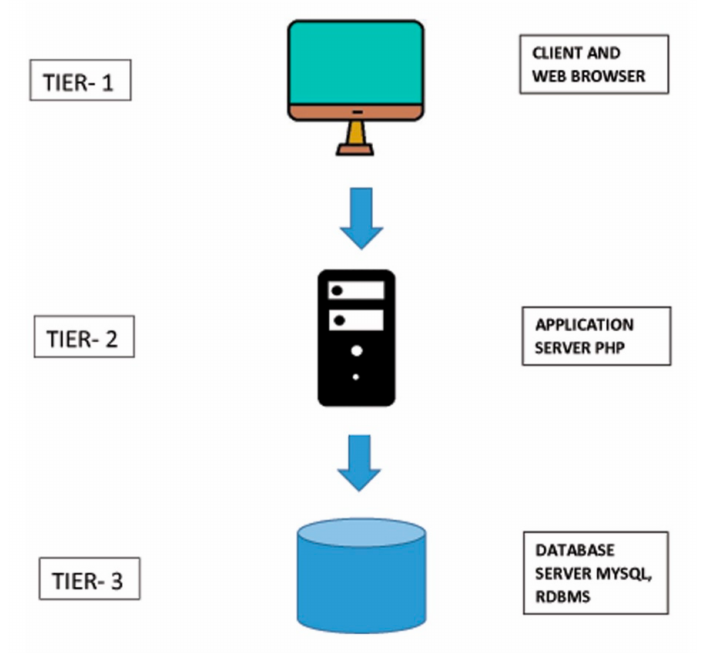
Figure 1. Three-tier architecture of